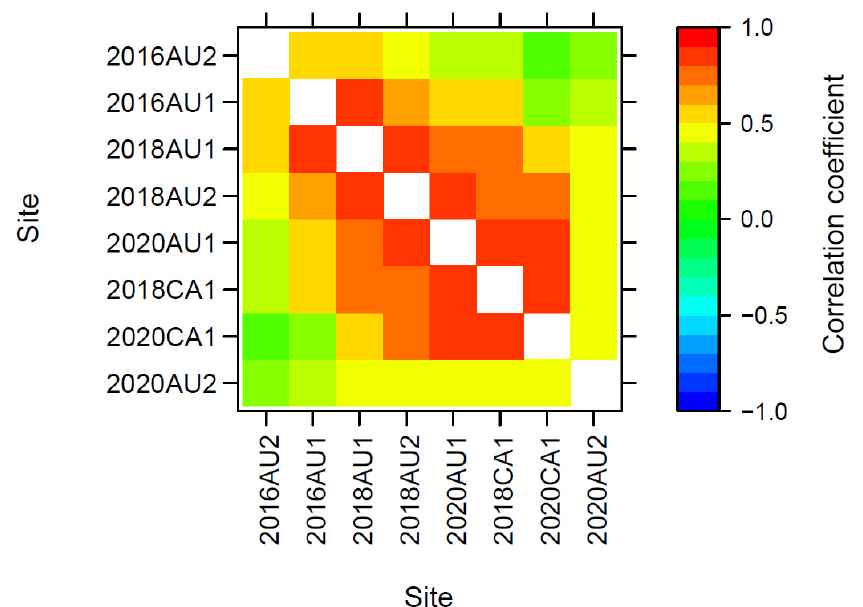
Figure 5. Genetic correlations of additive effects for grain yield across trial sites from the optimum MMM-FA model of the genotype × environment effects (see Table 2). For description of trial codes, see Table 1.